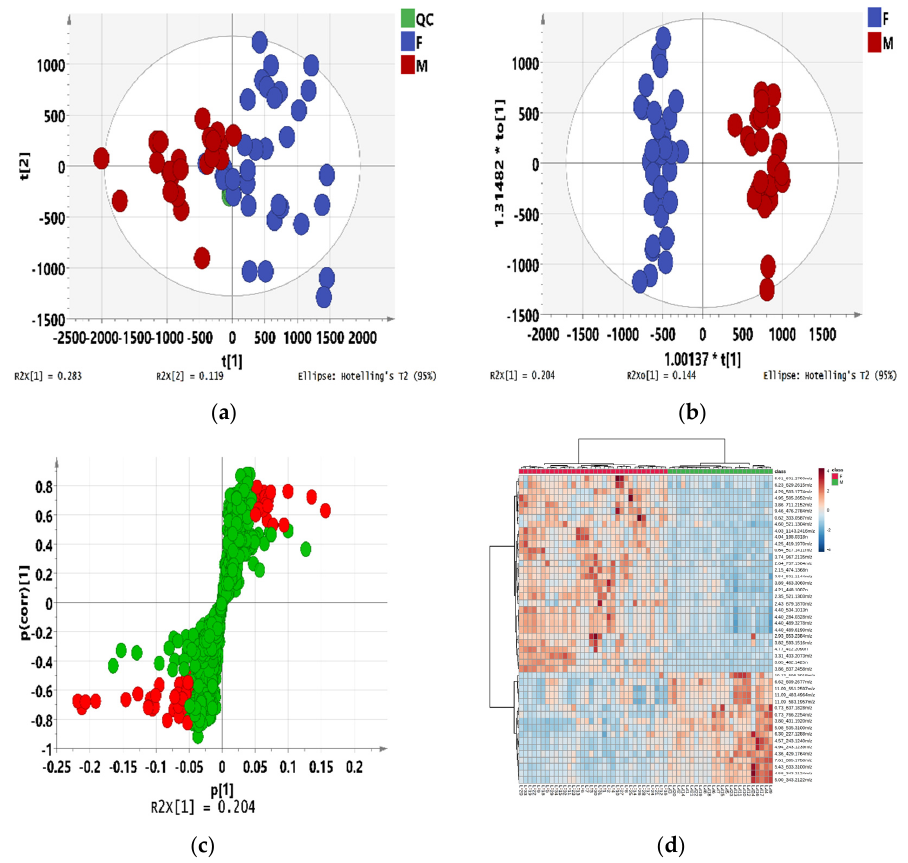
Figure 1. Chemometrics of male and female leaf samples. ( a ) PCA score plot; ( b ) OPLS-DA score plot; ( c ) S-plot of OPLS-DA along with selected candidate differential metabolites (cut-off values of |p| ≥ 0.05 and |p(corr)| ≥ 0.5); ( d ) Heat-map and hierarchical clustering analysis (HCA) analyses of metabolite contents in male and female leaf samples.